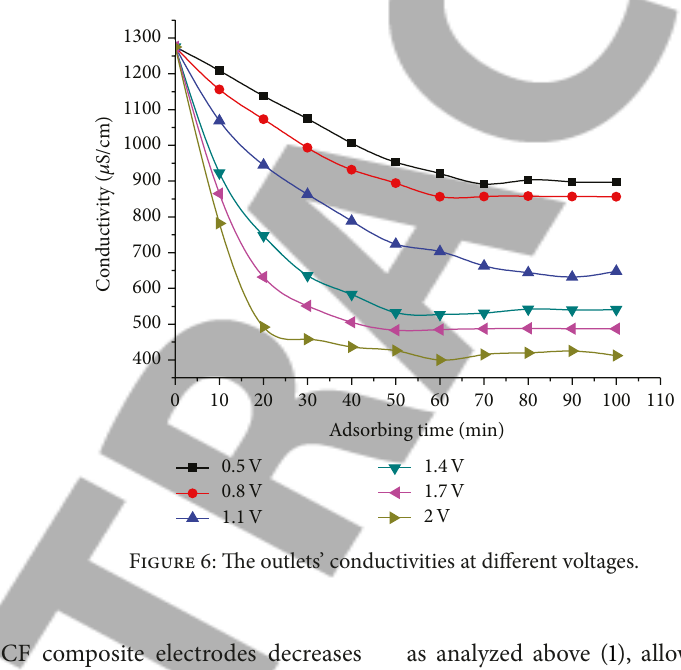
Figure 6: The outlets’ conductivities at different